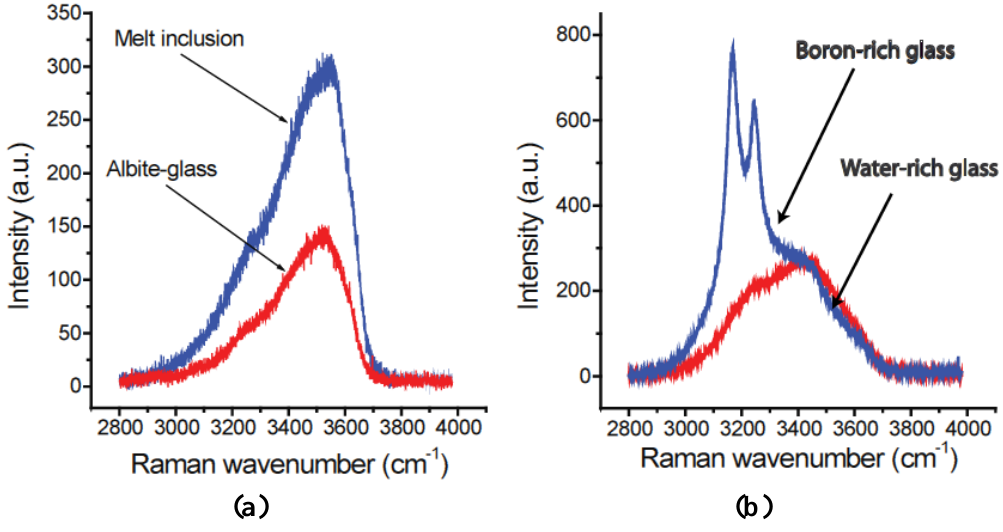
Figure 1. ( a ) Typical Raman spectra in the high frequency range of a melt inclusion glass (sample MX-4), homogenized at 700 °C and 1 kbar in comparison to a synthetic albite glass (Ab-83) with 11.71% (g/g) water, determined with the Karl-Fisher method (see [19]). ( b ) Raman spectra from very H BO -rich melt inclusion glasses and a water-rich 3 3